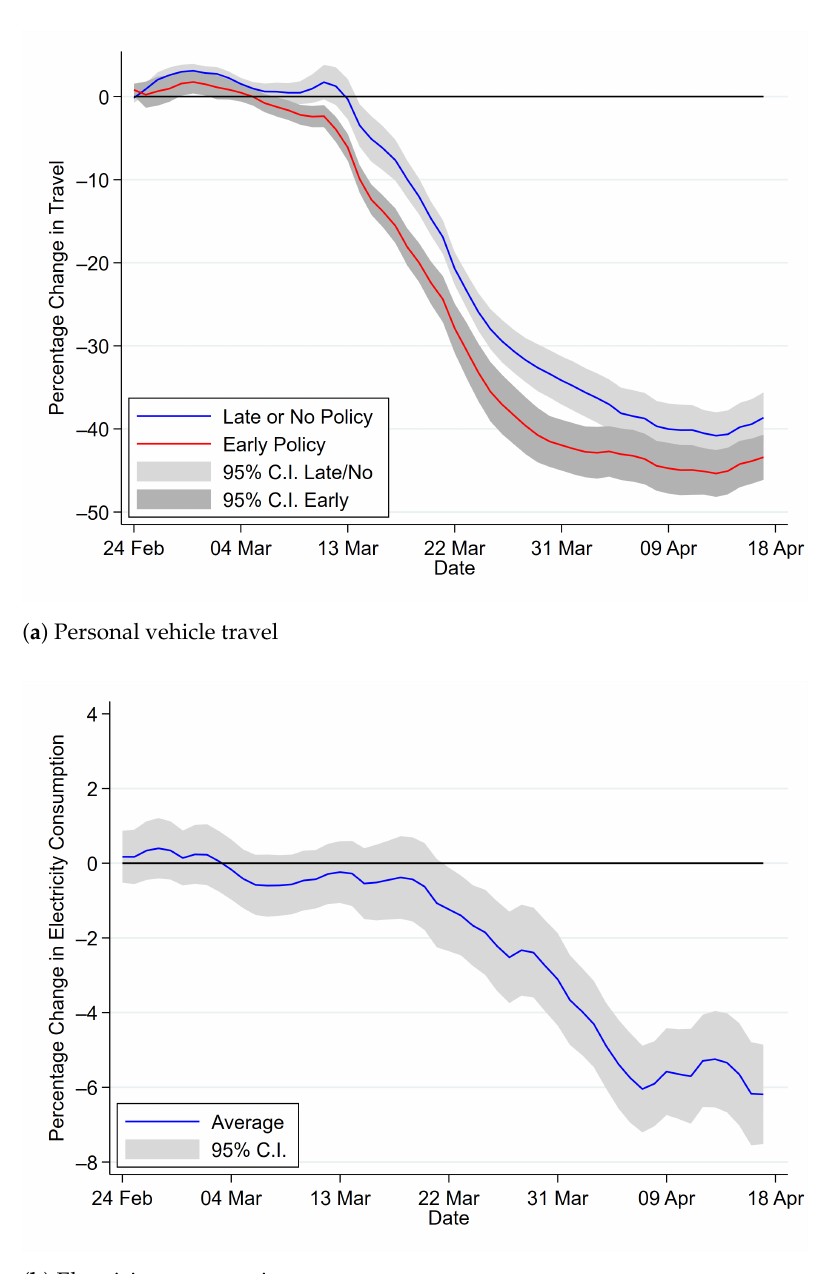
Figure 1. Effect of social distancing on travel and electricity consumption. Notes: Seven day moving averages. Data from [26,29]. Early-policy states put a stay-at-home policy in place by 28 March 2020. Shaded area indicates 95% confidence